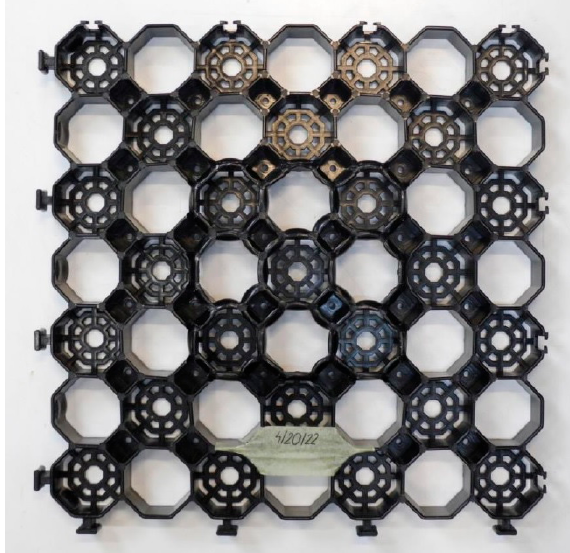
Figure 14. Image of the geocell after the test.